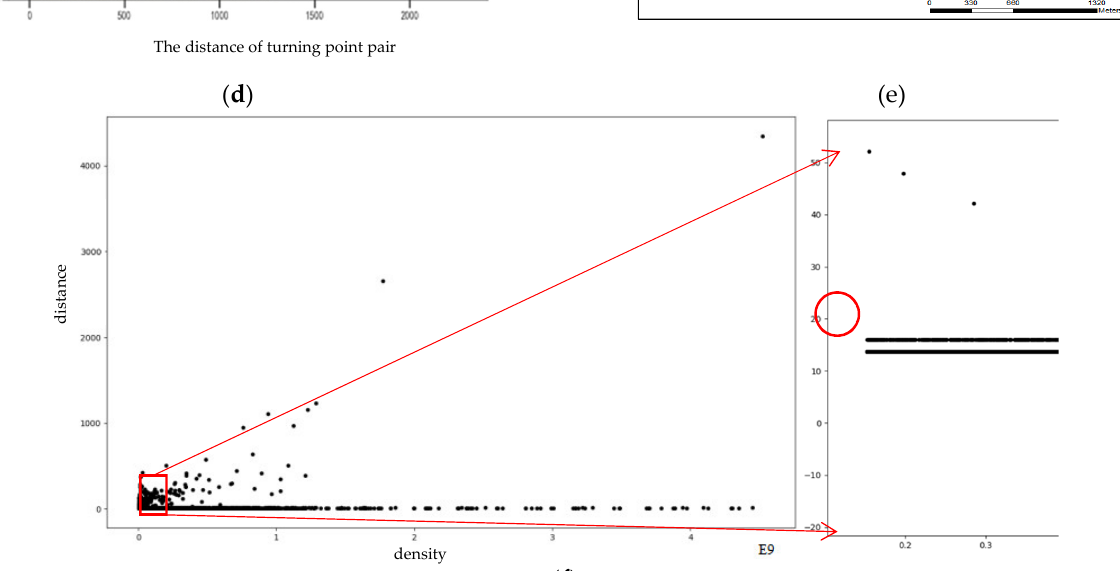
Figure 4. Road intersections extraction. ( a ) Turning point vectors; ( b ) converging points; ( c ) extraction results of distance limited; ( d ) distance statistics; ( e ) Kernel density; ( f )The decision graph of δ qi and ρ i (the right picture is part of the amplified